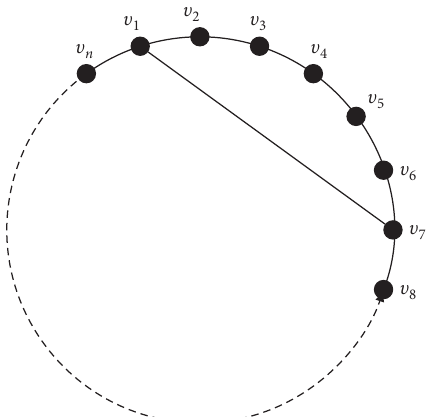
Figure 2: The cycle with a chord graph C